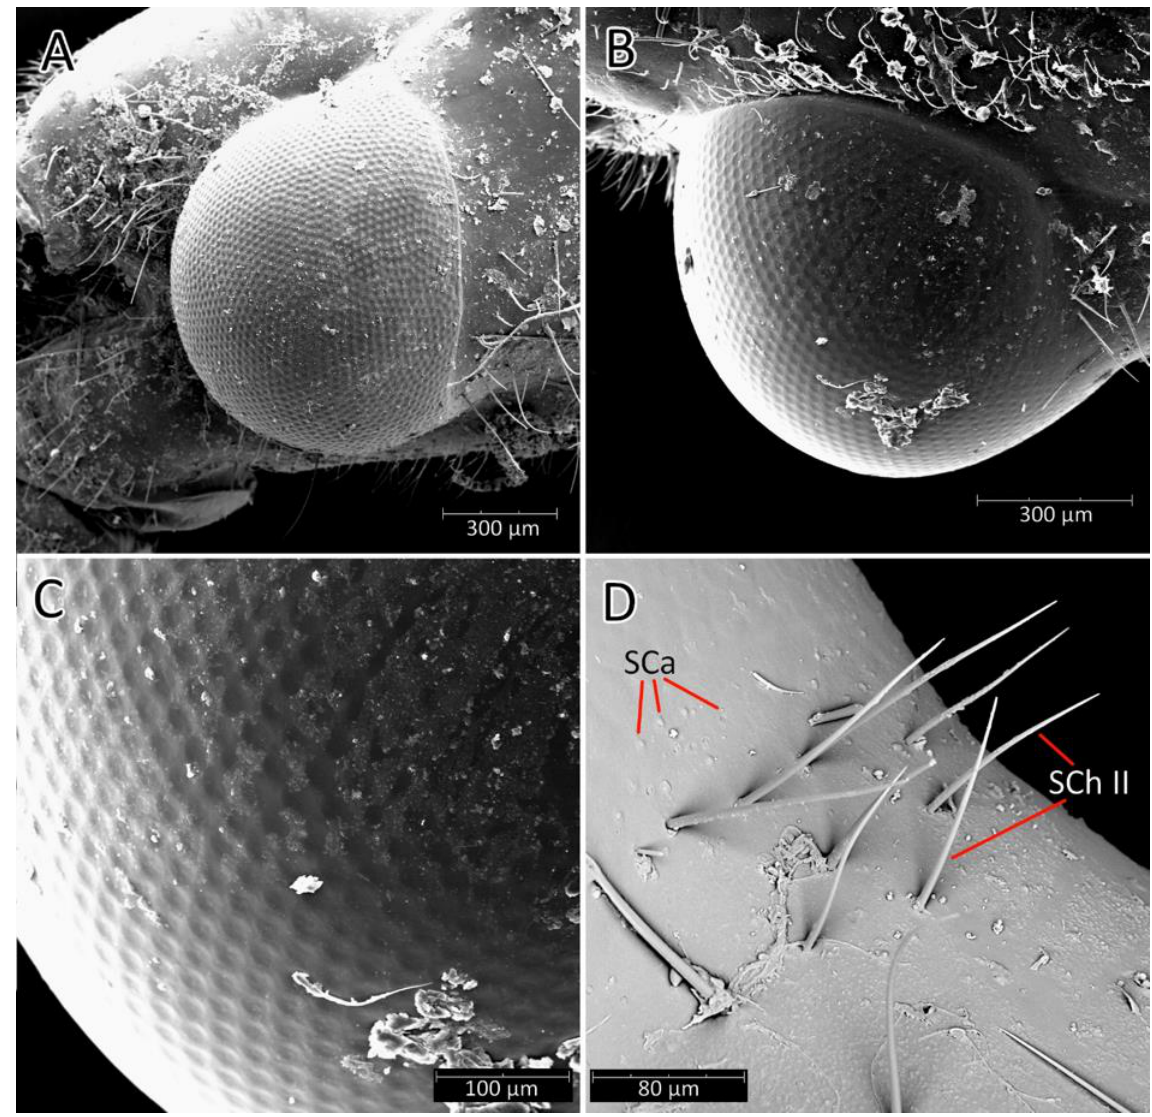
Figure 7. Phonoctonus fasciatus (Beauvois, 1805): ( A ) head with a compound eye, lateral view; ( B ) compound eye, ventral view; ( C ) magnification of the compound eye ommatidia; ( D ) base of the eye with sensilla chaetica type II ( SCh II ) and sensilla campaniformia ( SCa ).